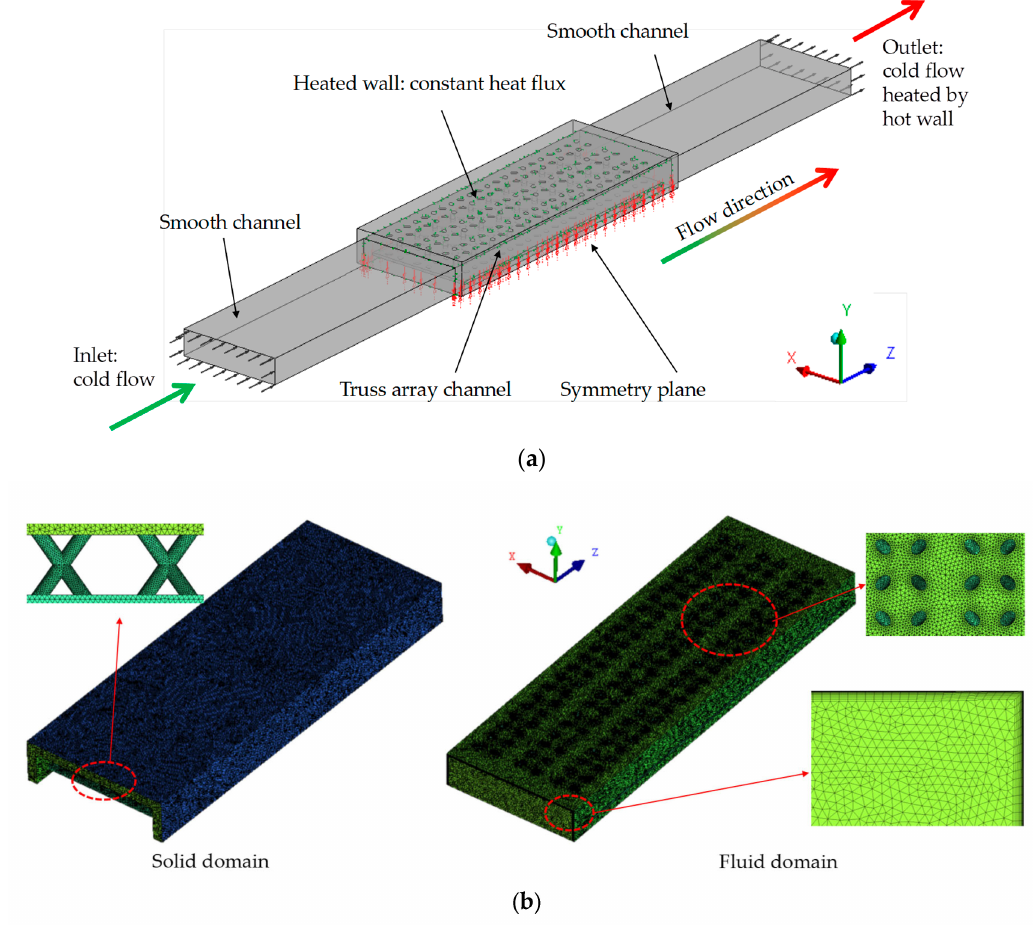
Figure 2. Numerical calculation model (Scheme 3: h/H = 0.35): ( a ) numerical model; ( b ) grid